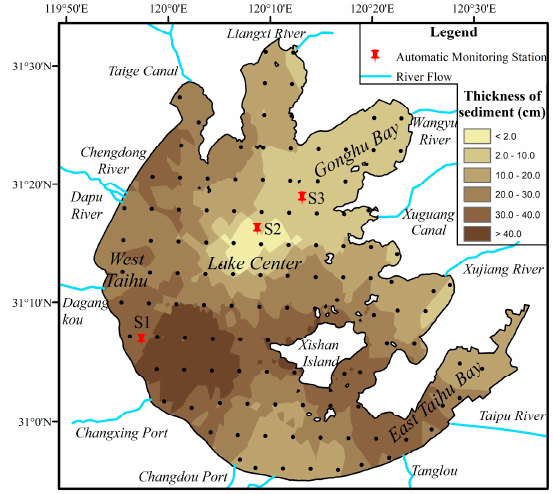
Figure 3. Spatial distribution of sediments in Lake Taihu. Table 2. Statistical characteristics of turbidity, wind speed, and chlorophyll- a (Chl- a